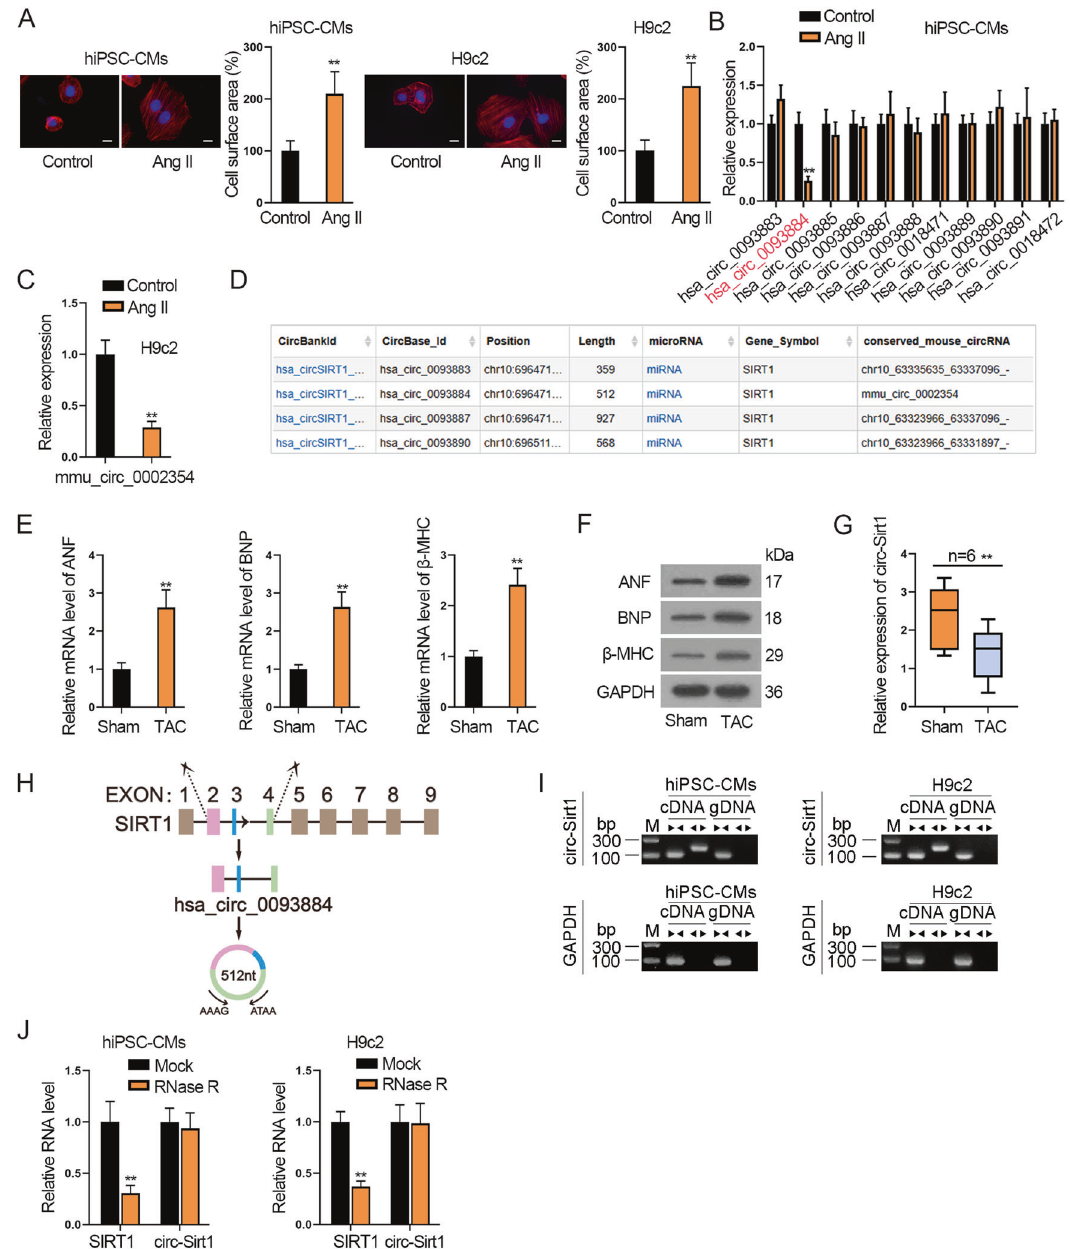
Fig. 1 Circ-SIRT1 and its homologous circ-Sirt1 are low-expressed in the CH model in vitro and in vivo. A The surface area of hiPSC-CMs and H9c2 cells treated without (control) or Ang II was observed by immuno fl uorescence staining of α -actinin (red). Scale bar, 10 μ m. N = 3. B RT-qPCR was applied to analyze the expressions of circRNAs associated with SIRT1 gene in Ang II-treated hiPSC-CMs. N = 3. C RT-qPCR analysis of mmu_circ_0002354 (circ-Sirt1) expression in Ang II-treated H9c2 cells versus non-treated H9c2 cells. N = 3. D According to the searching results in bioinformatics website circBank, mmu_circ_0002354 (circ-Sirt1) in conserved human homolog is hsa_circ_0093884 (circ-SIRT1). E , F The expression of CH markers (ANF, BNP, and β -MHC) in the TAC group ( N = 6) and sham group ( N = 6) was examined via RT-qPCR and western blot analyses. G RT-qPCR detection of circ-Sirt1 expression in the hearts of mice subjected to TAC surgery (TAC group, N = 6) and sham operation (sham group, N = 6). H Schematic illustration displayed the circularization of SIRT1 exon 2 – 4 to form hsa_circ_0093884 (circ-SIRT1). I Nucleic acid electrophoresis uncovered that divergent primers could produce the circular isoform of SIRT1 (or Sirt1) with cDNA but not with gDNA in hiPSC-CMs (or H9c2 cells). GAPDH was an internal control. N = 3. J The abundance of circ-SIRT1/circ-Sirt1 or linear RNA SIRT1/Sirt1 analyzed via RT-qPCR after RNase R treatment in hiPSC-CMs (or H9c2 cells). N = 3. ** P < 0.01 was assessed by Student ’ s t